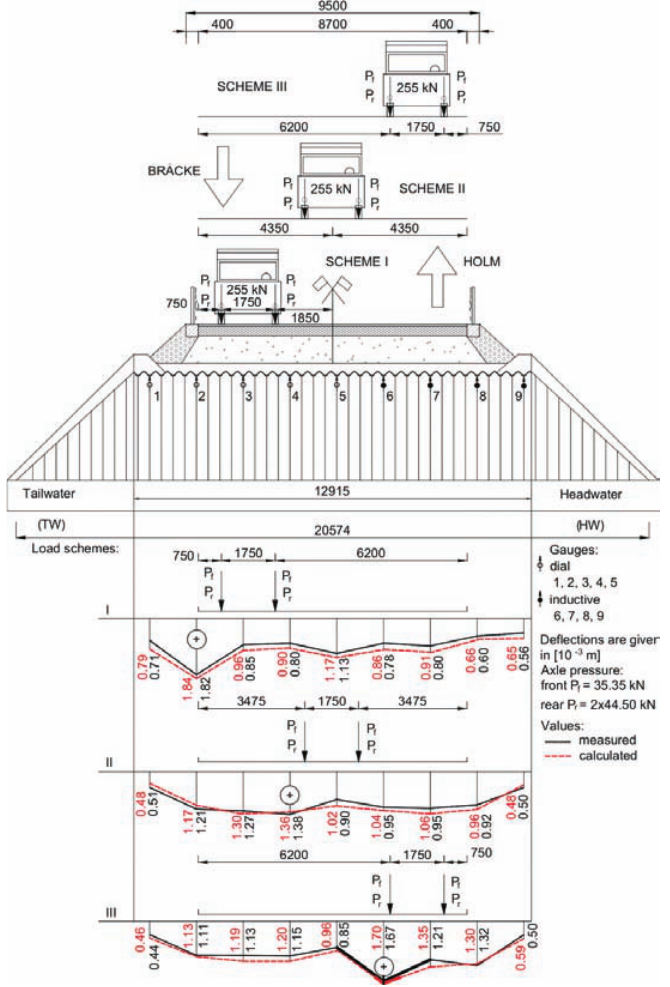
fig. 10. Graphs of max deflections obtained from measurements and calculations in transversal direction of the span for 3 test load